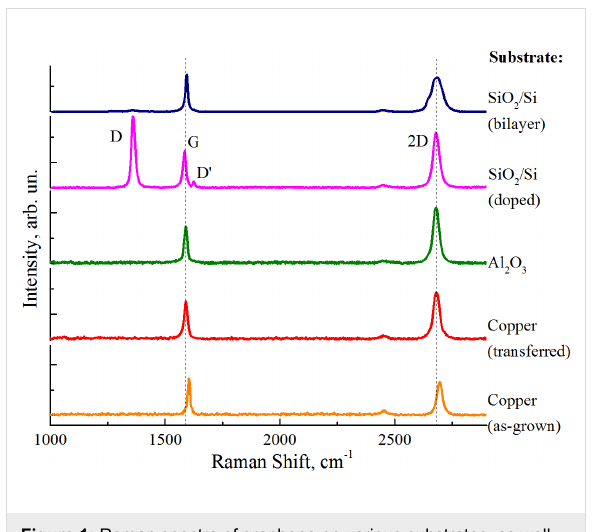
Figure 1: Raman spectra of graphene on various substrates, as well as bilayer and nitrogen-doped